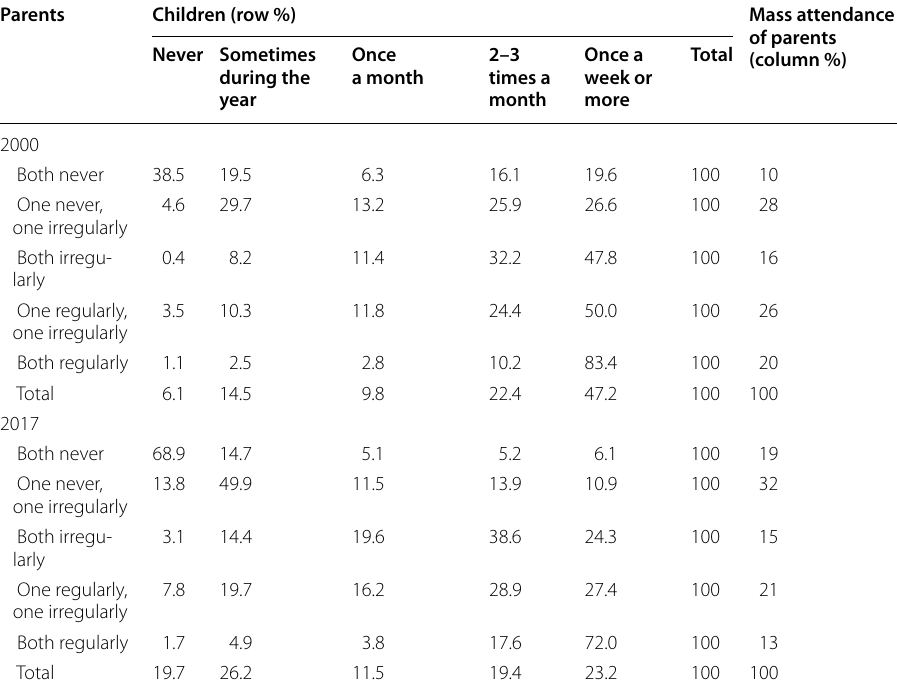
Source: authors’ elaboration on SIS and SELFY surveys data